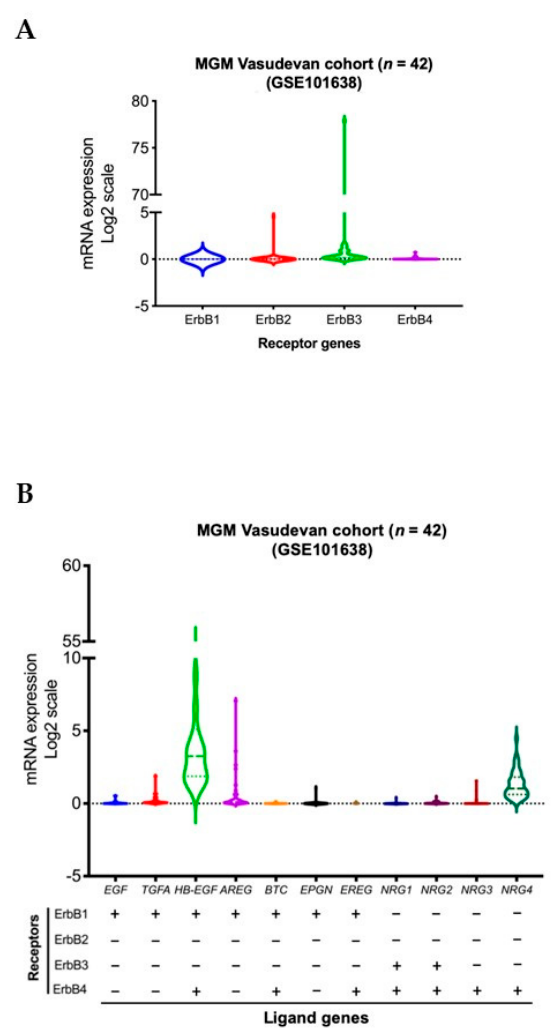
Figure 1. Transcript levels of members of the ErbB RTK family and their ligands in aggressive MGM, n = 42 MGM samples [84]. Expressions of genes for ErbB receptors ( A ) and ligands ( B ) across all samples are presented in violin format as log2-transformed signal